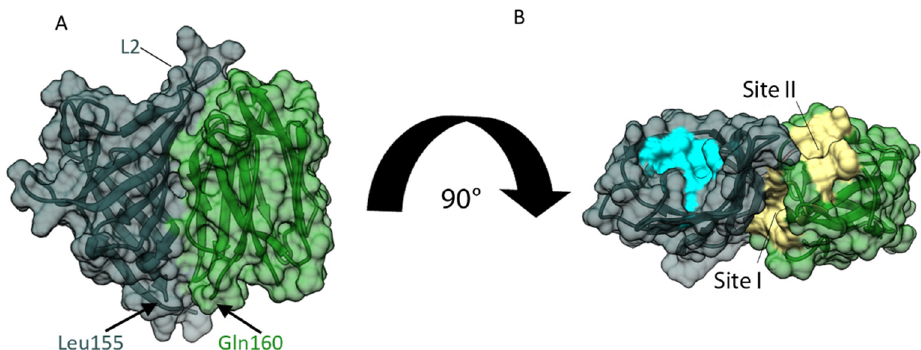
Figure 6. Interaction of individual Os JAC1 domains analyzed through protein–protein docking using HADDOCK [34]. Docking was performed with chain A (cf1) of the respective domains. ( A ) Proposed complex of JRL (green) and DIR domain (metallic) shown as ribbon model with additional transparent surface view. A linker with four residues is missing between DIR domain (C-terminus at Leu155) and JRL domain (N-terminus at Gln160). ( B ) Rotated view of panel A. Ligand binding sites of the JRL and DIR domains are highlighted in yellow and blue, respectively. Note that loop L2 of the DIR domain is positioned close to sites I and II of the JRL domain.